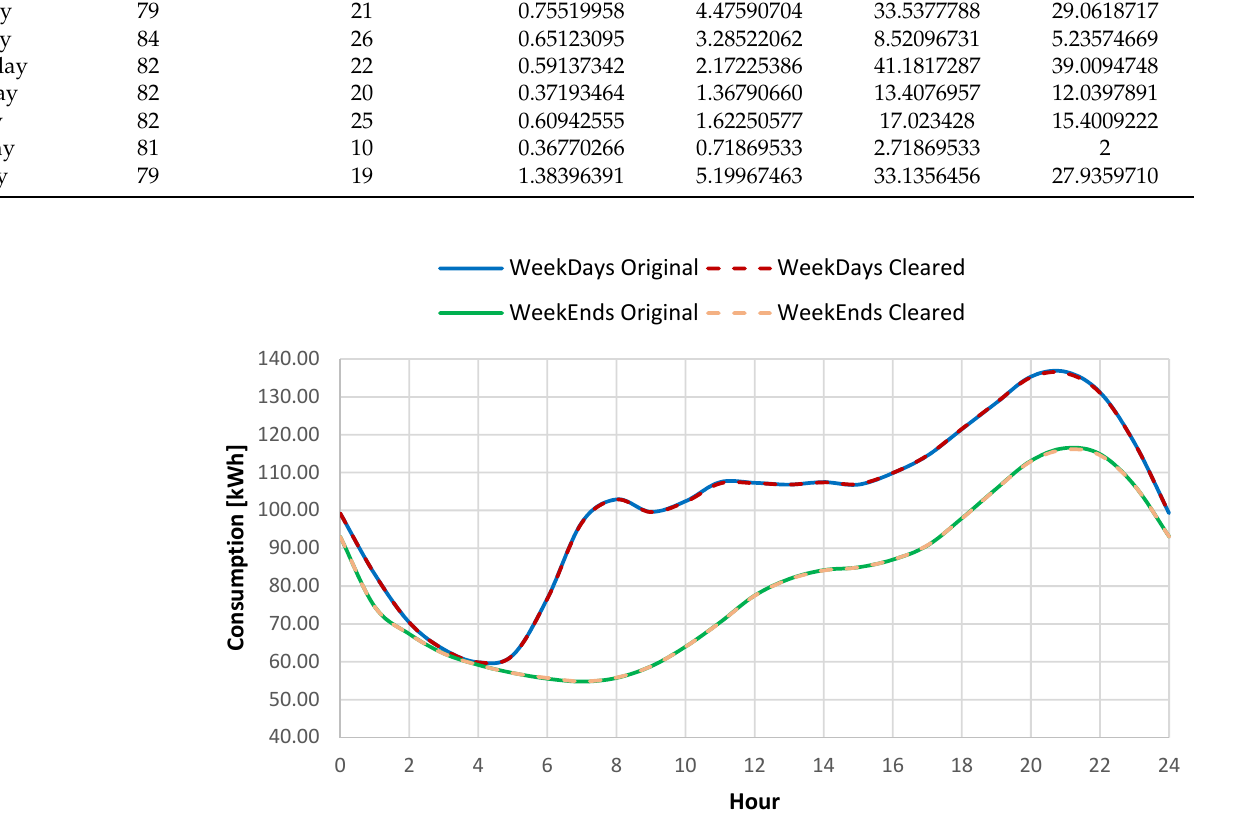
Figure 20. Daily consumption baseline for the original and cleared data sets.